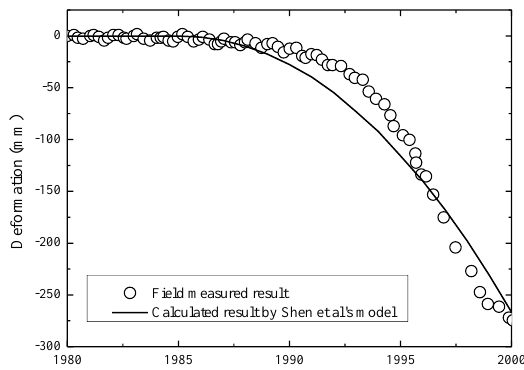
Figure 2. Groundwater level and deformation of AqIV in Yangpu district, Shanghai (Data from Wei et al., 2010b).